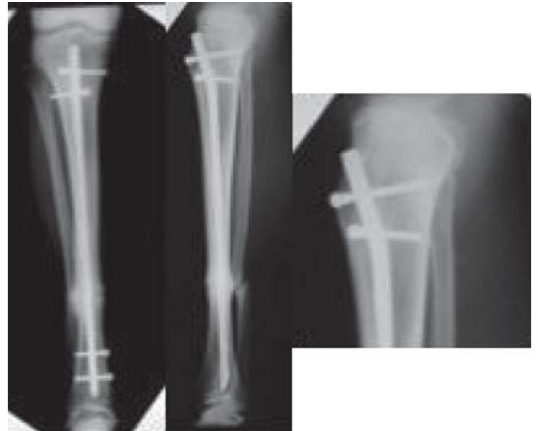
Figure 4 - Patient with healed fracture without evidence of nail extrusion but still suffering knee